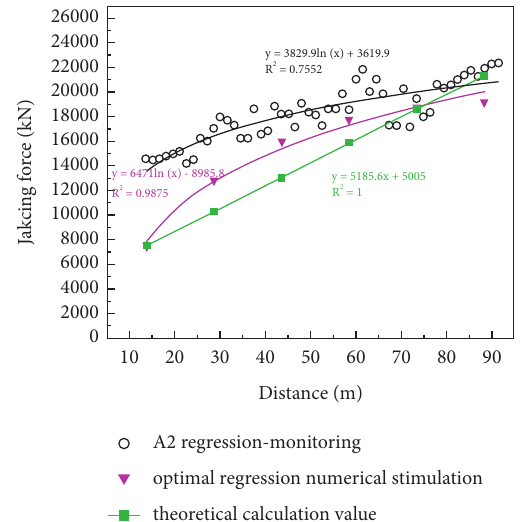
Figure 14: The comparison of jacking forces from monitoring, the empirical equations of A2, and the displacement control method for case A1 of optimal program (program 4).